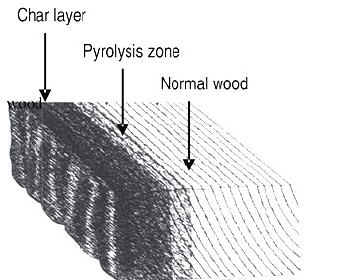
Fig. 1. Wood destruction scheme (Lipinskas, Mačiulaitis